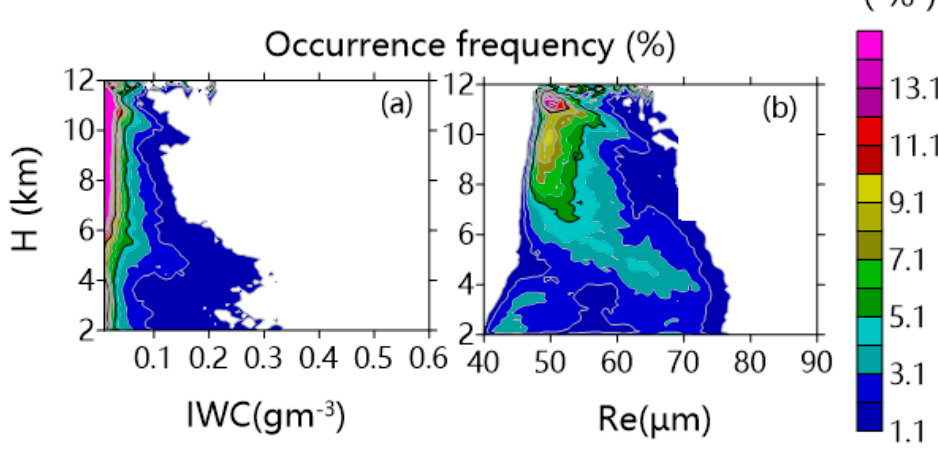
Figure 8. CFADs (%) for ( a ) IWC and ( b ) radius (Re) above the bright band during July 2014.